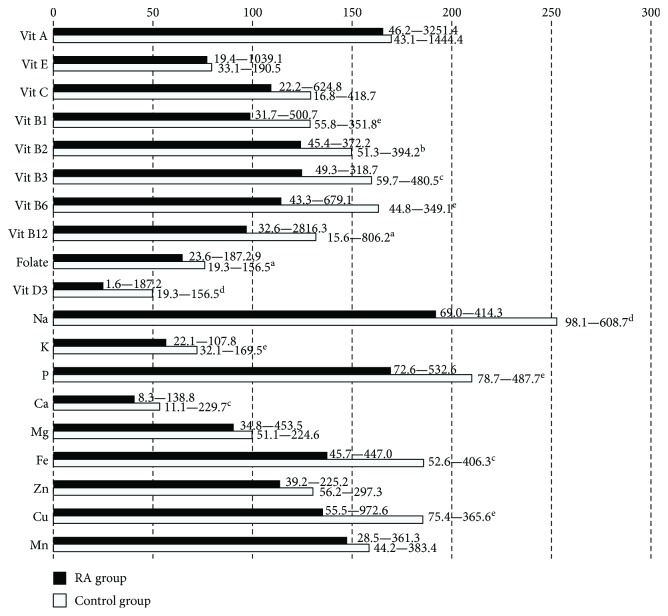
Micronutrient intake in RA and control groups (% of recommendations)—median and range. The values expressed in % RDA, except for vitamin E, Na, and K (% AI) and Mn (mean AI in European countries). Statistically significant differences (p value): a<0.05, b<0.01, c<0.005, d<0.001, e<0.0001.